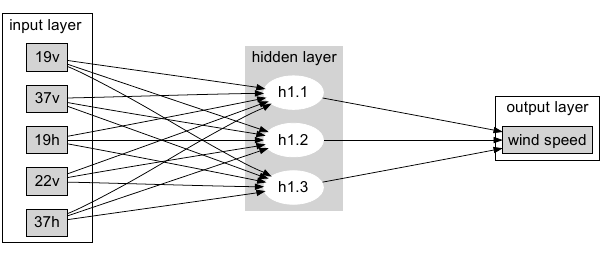
Figure 10. Neural network architecture of the near surface wind speed algorithm.